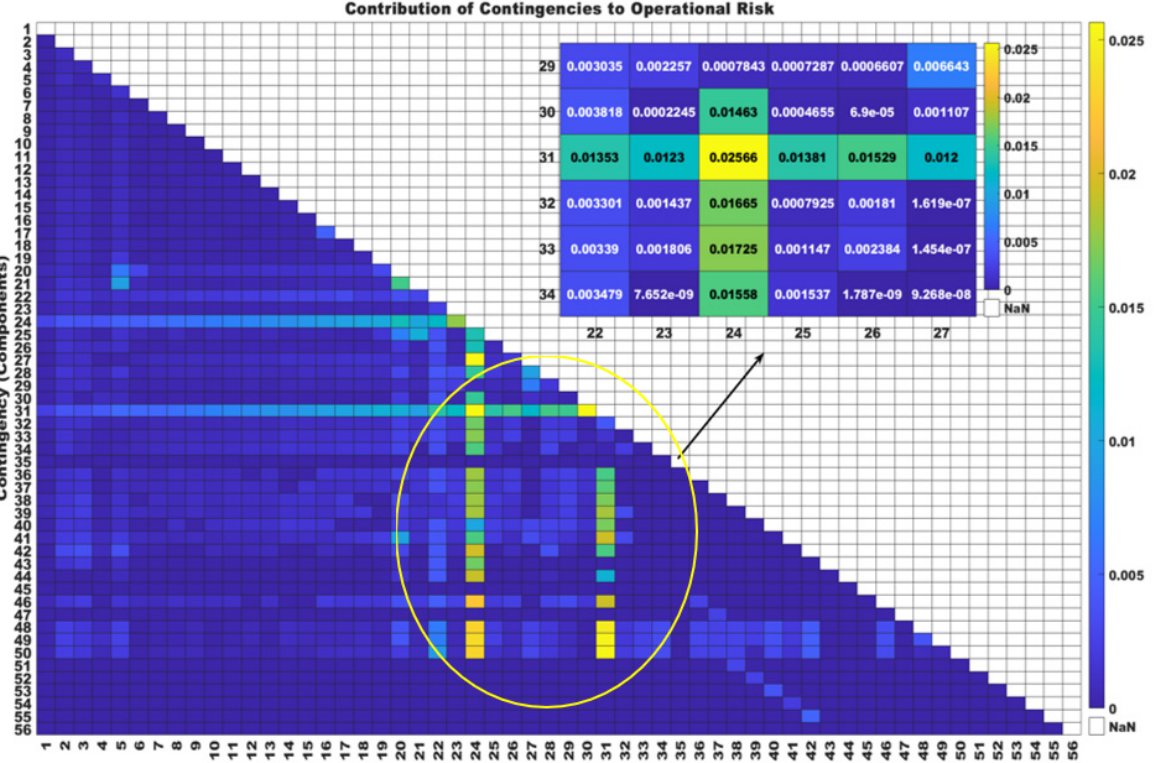
Figure 5. Contribution of contingencies towards OROV (OS-1). The color scale indicates the contribution of each contingency (defined by Equation (8)), as quantified by the color bar on the right, in the relevant unit. The color scale is selected such that the lowest value is dark blue and the highest value is yellow.